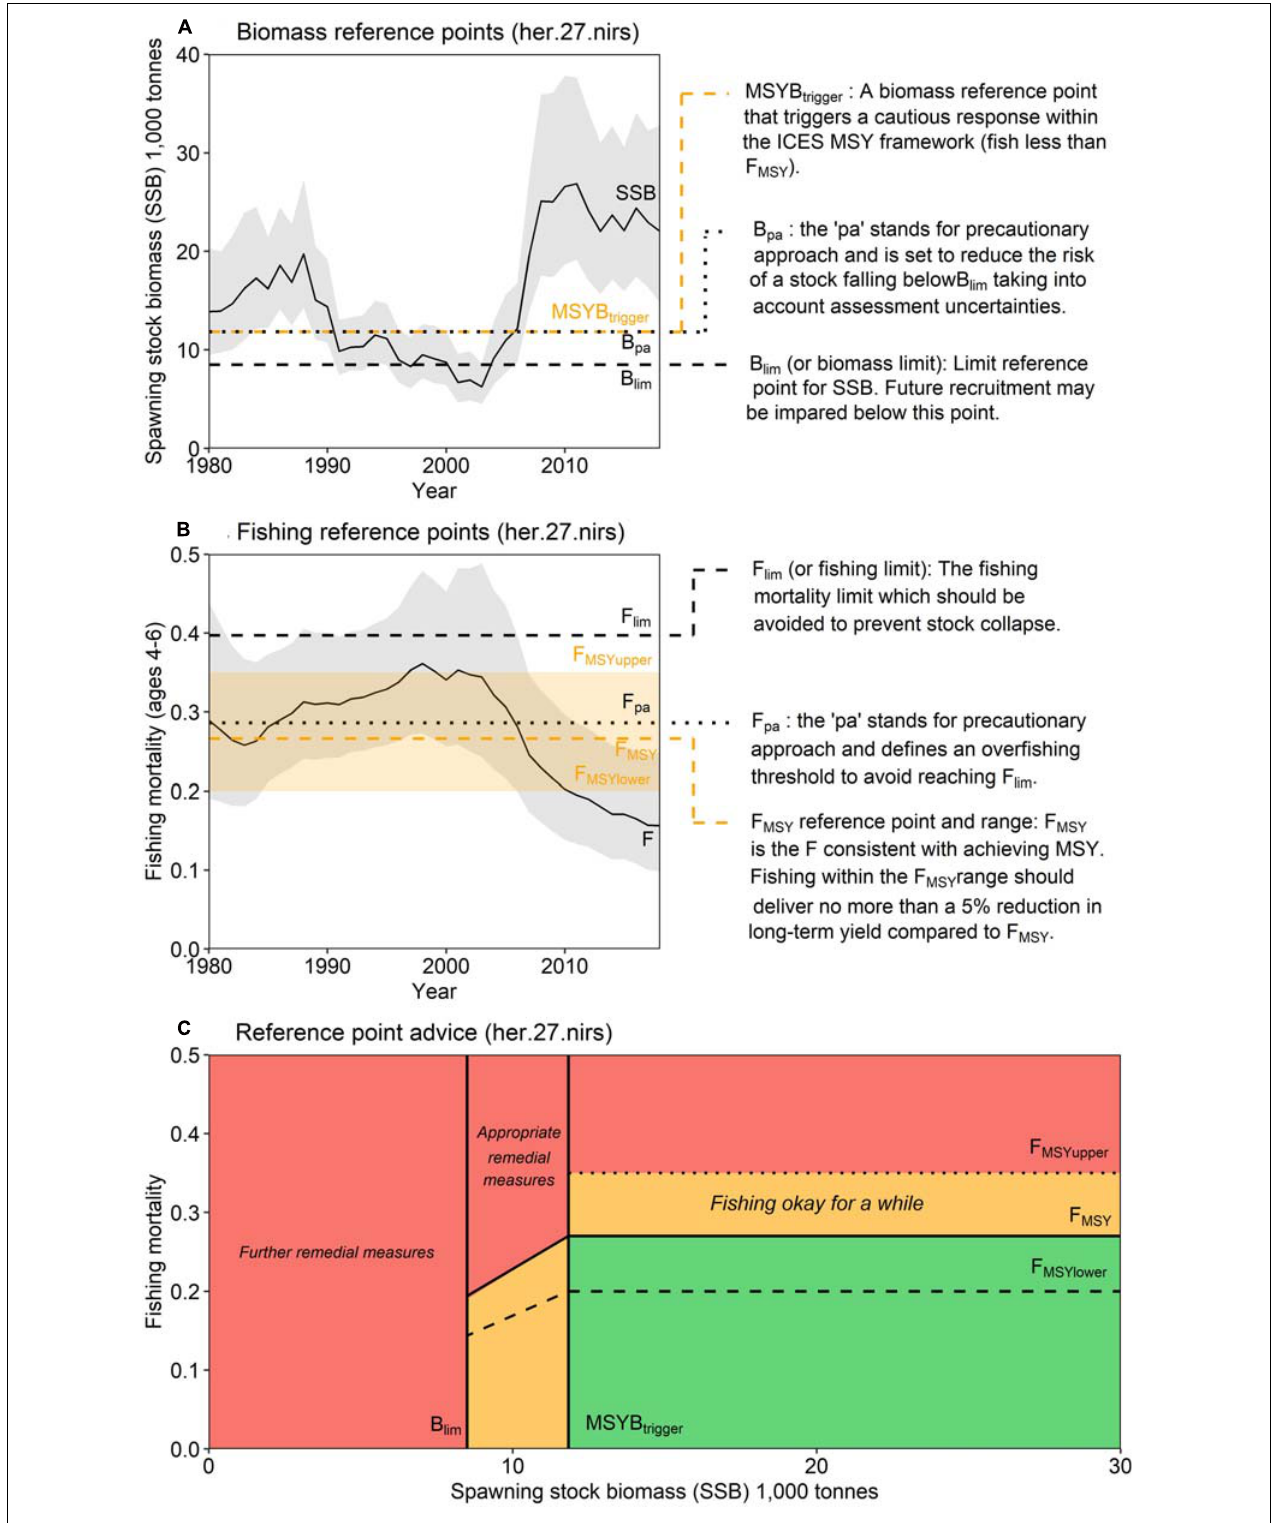
FIGURE 1 | ICES fishing and reference points for Irish Sea herring (her.27.nirs). ICES provide (A) biomass reference points, (B) fishing reference points, (C) and an advice rule to ensure fisheries management advice is consistent with the precautionary principle.